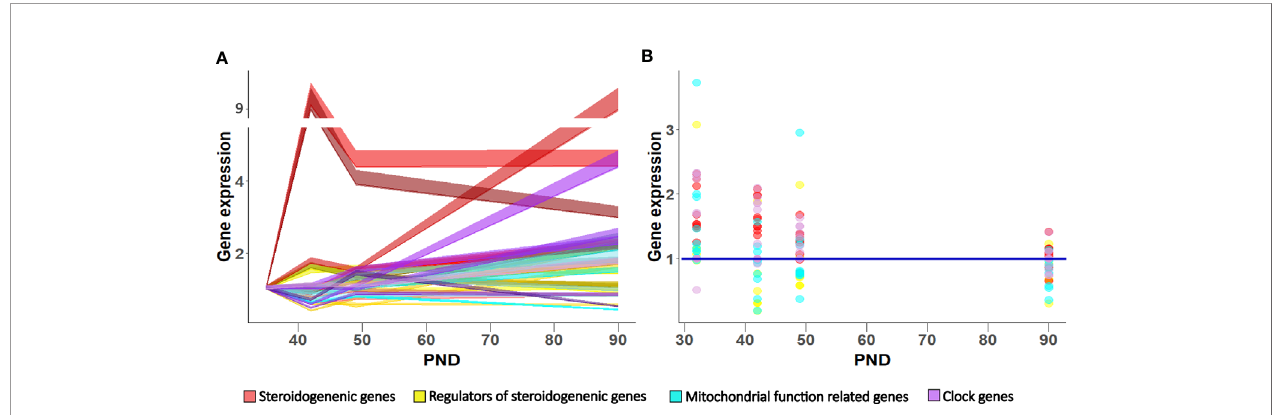
FIGURE 7 | Gene expression pattern in Leydig cells during maturation in LD (A) and LL condition (B). Data shown represent expression pattern of genes important for steroidogenesis, mitochondrial function and clock during Leydig cell maturation (A) relative to P35. Ribbons represent 95% con fi dence intervals. Effect of growing up in constant light regime on Leydig cell gene expression (B) . Points represent a deviation in the expression of a particular gene in LL condition in respect to corresponding LD (control value = 1; blue